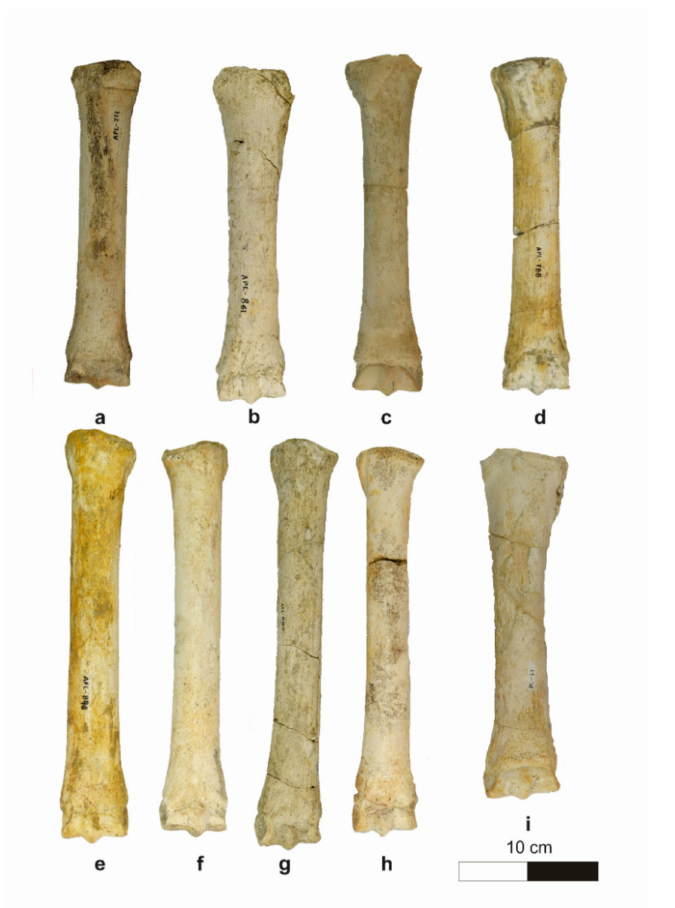
Figure 7. Equus apolloniensis , ( a – d ) third metacarpals, ( a ) APL-777, ( b ) APL-801, ( c ) APL-157, ( d ) APL-788; ( e – f ) third metatarsals, ( e ) APL-848, ( f ) APL-92, ( g ) APL-880, ( h ) APL-237; Equus sp., ( i ) third metacarpal,